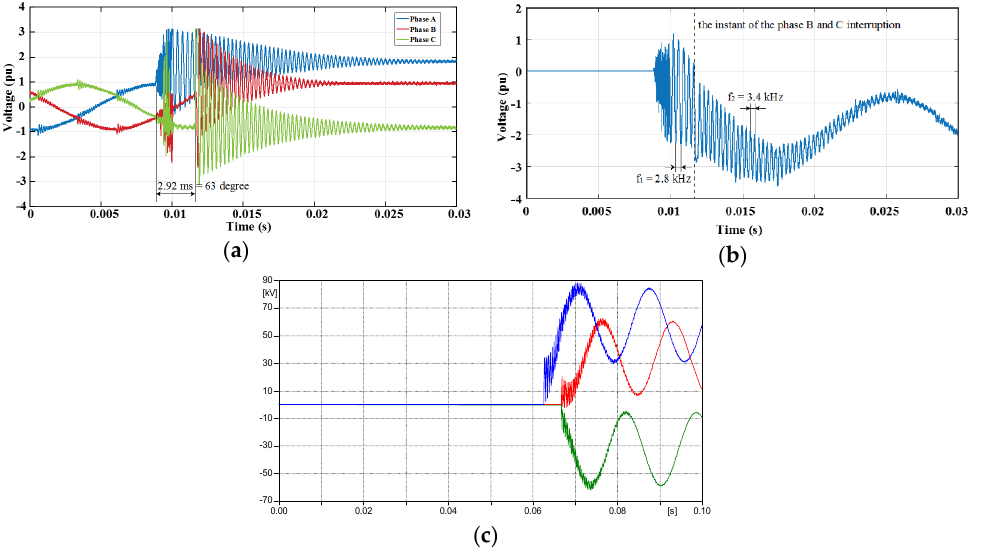
Figure 8. Transient voltages for three-phase filter interruption; ( a ) transient capacitor voltages during the interruption of the 2nd harmonic filter (field measurement); ( b ) transient recovery voltage for phase A interrupted first (field measurement) ( c ) transient recovery voltage for phase A interrupted first (simulation).